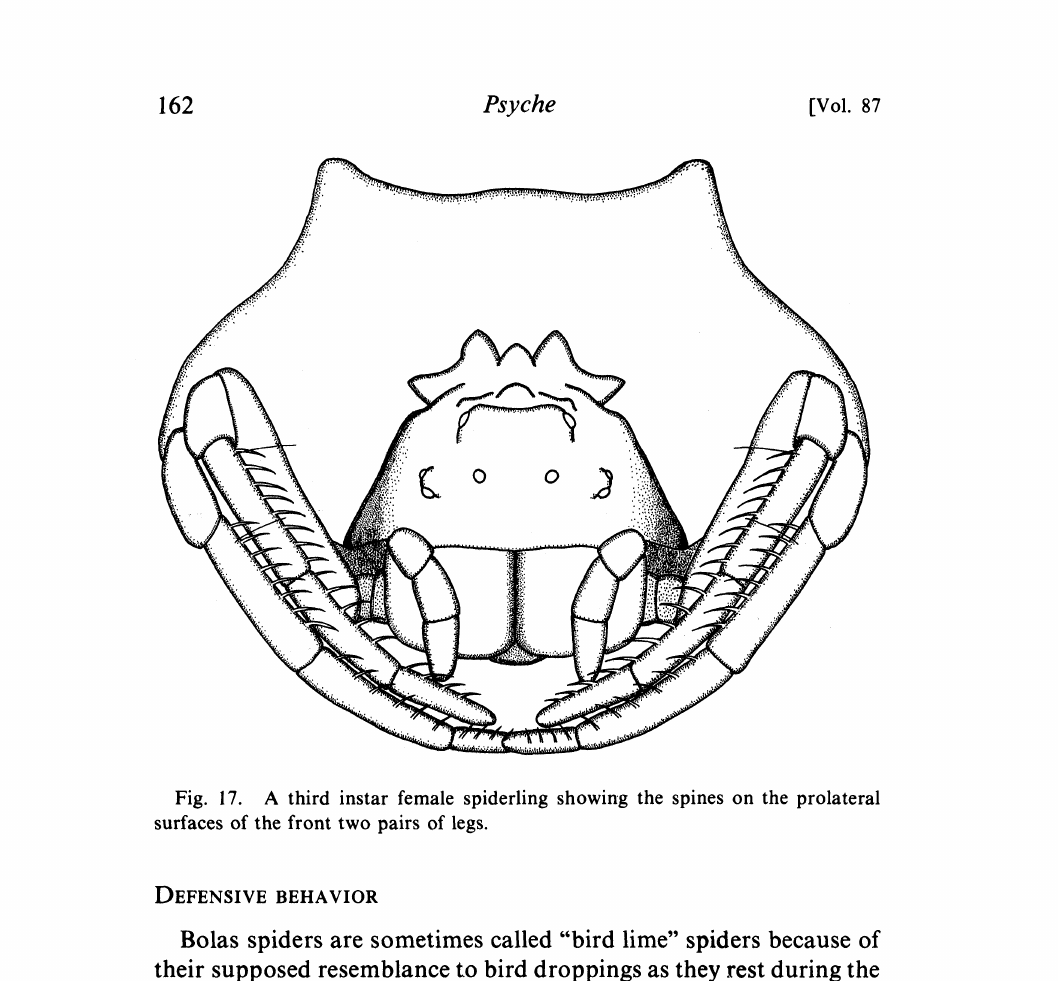
Fig. 17. A third instar female spiderling showing the spines on the prolateral surfaces of the front two pairs of